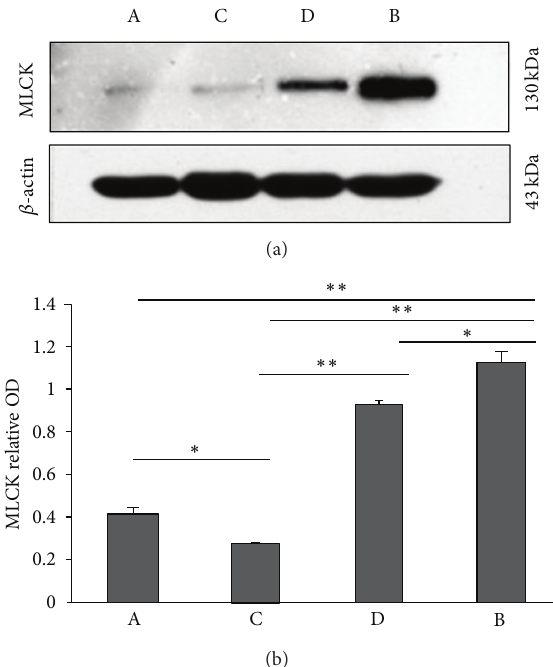
Figure 4: Western blot showed the expression of MLCK in hippocampal tissue in rats. (a) The representative photos of western blot. (b) The statistical analysis of western blot. Data shown are mean ± SEM. ∗ 𝑃 < 0.05 , ∗∗ 𝑃 < 0.01